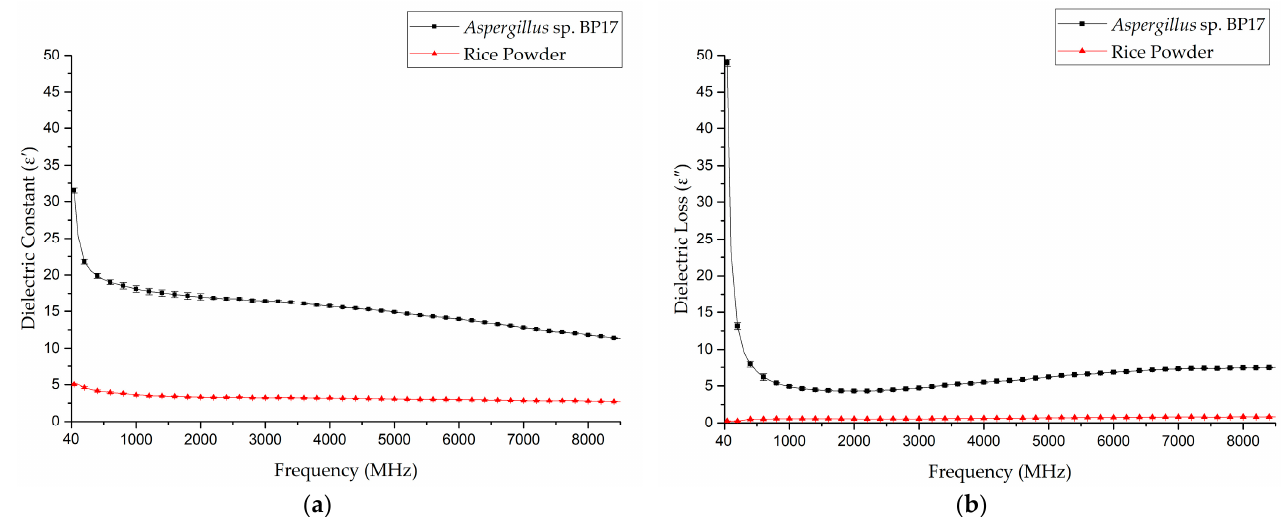
Figure 5. Dielectric properties of Aspergillus sp . BP17 and rice powder: ( a ) Dielectric constant ( ε′ ) and ( b ) Dielectric loss ( ε″ ). ( b ) Dielectric loss ( ε (cid:48)(cid:48)